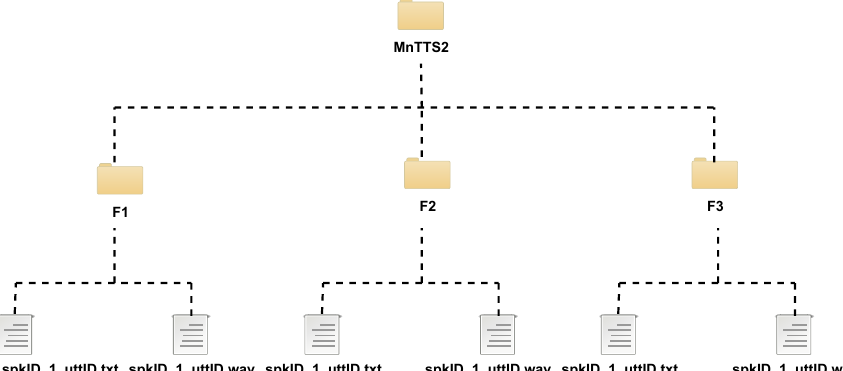
Figure 1. The folder structure of the MnTTS2 corpus.